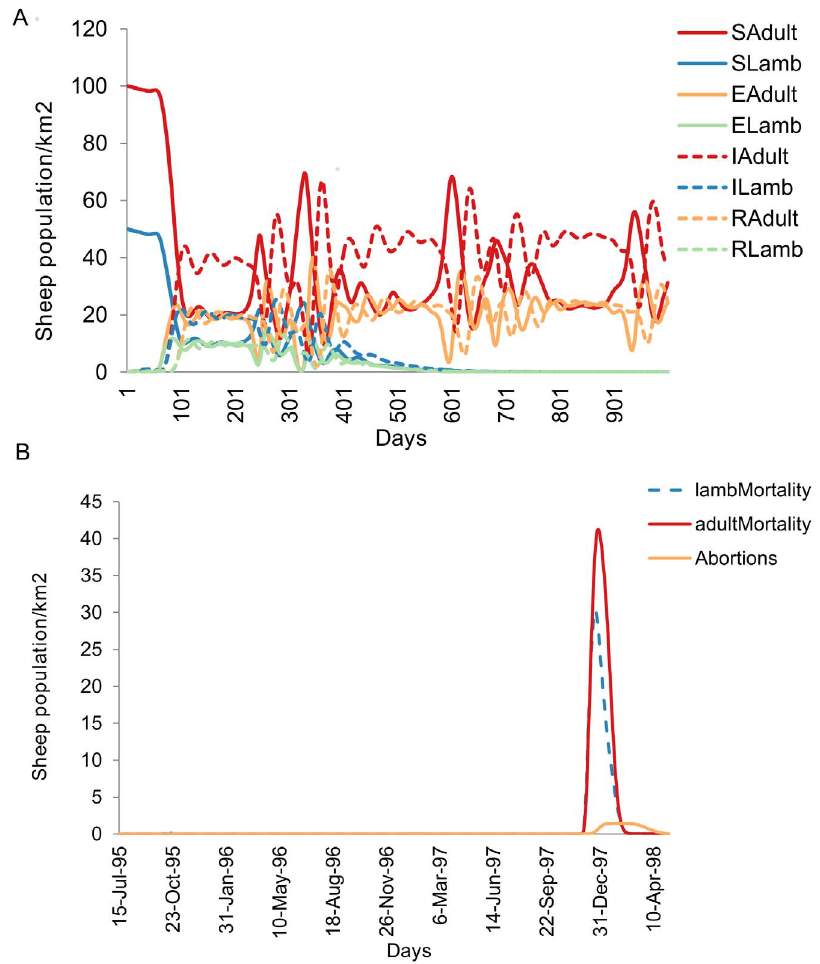
Figure 6. Simulated RVF epidemic. (A) Compartmental phases after allowing infection to flow from Aedines to Culicines for virus amplification, recovered hosts are not allowed to flow back into the susceptible hosts. (B) Calculated host mortality per developmental stages due to infection with RVF virus. Abbreviations : SAdult=Susceptible adults, SLamb=Susceptible lamb, EAdult=Exposed adult, ELamb=Exposed lamb, IAdult=Infectious adult, ILamb=Infectious lamb, RAdult=Recovered adult, RLamb=Recovered lamb.